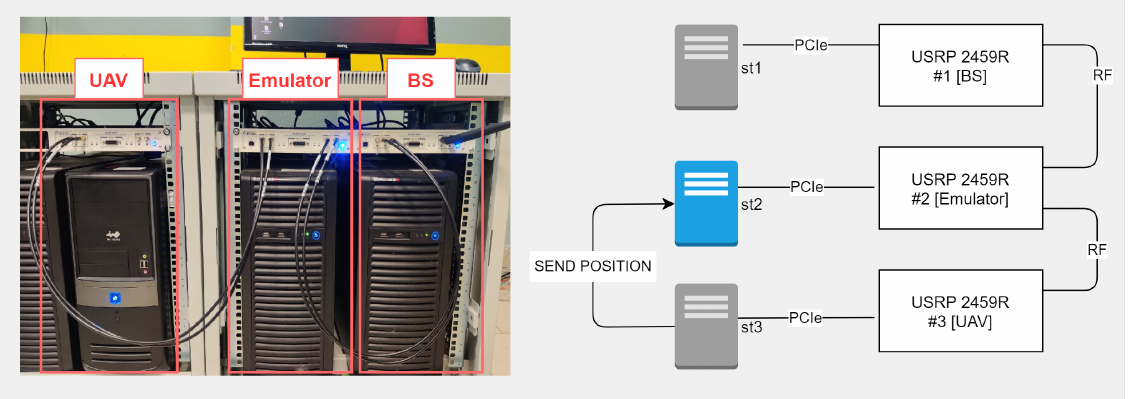
Figure 5. Testbed picture base station-UAV connection. (OFDMA 3300 MHz, QAM 256, bandwidth 40